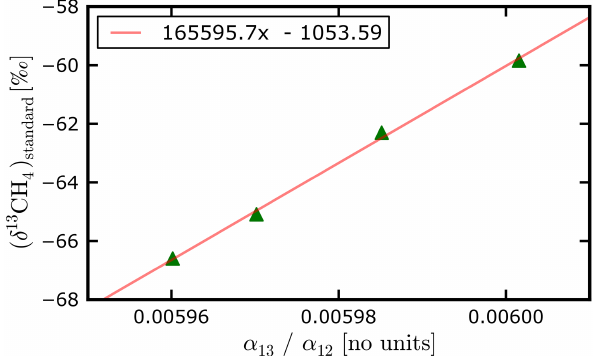
Figure 3. Isotope calibration experiment, using samples prepared for this work and then analyzed at a commercial isotope laboratory. The x axis shows the raw loss ratio provided by the instrument, and the y axis are the results of the external analysis. The linear fit coefficients have been applied to all CRDS instruments that use these spectroscopic lines for δ 13 CH 4 quantification.